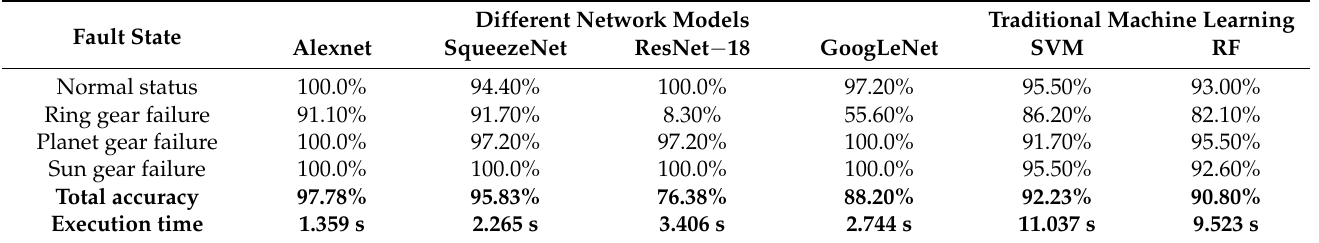
Table 6. Comparative analysis of fault diagnosis between different network models and traditional methods when CR = 0.5.